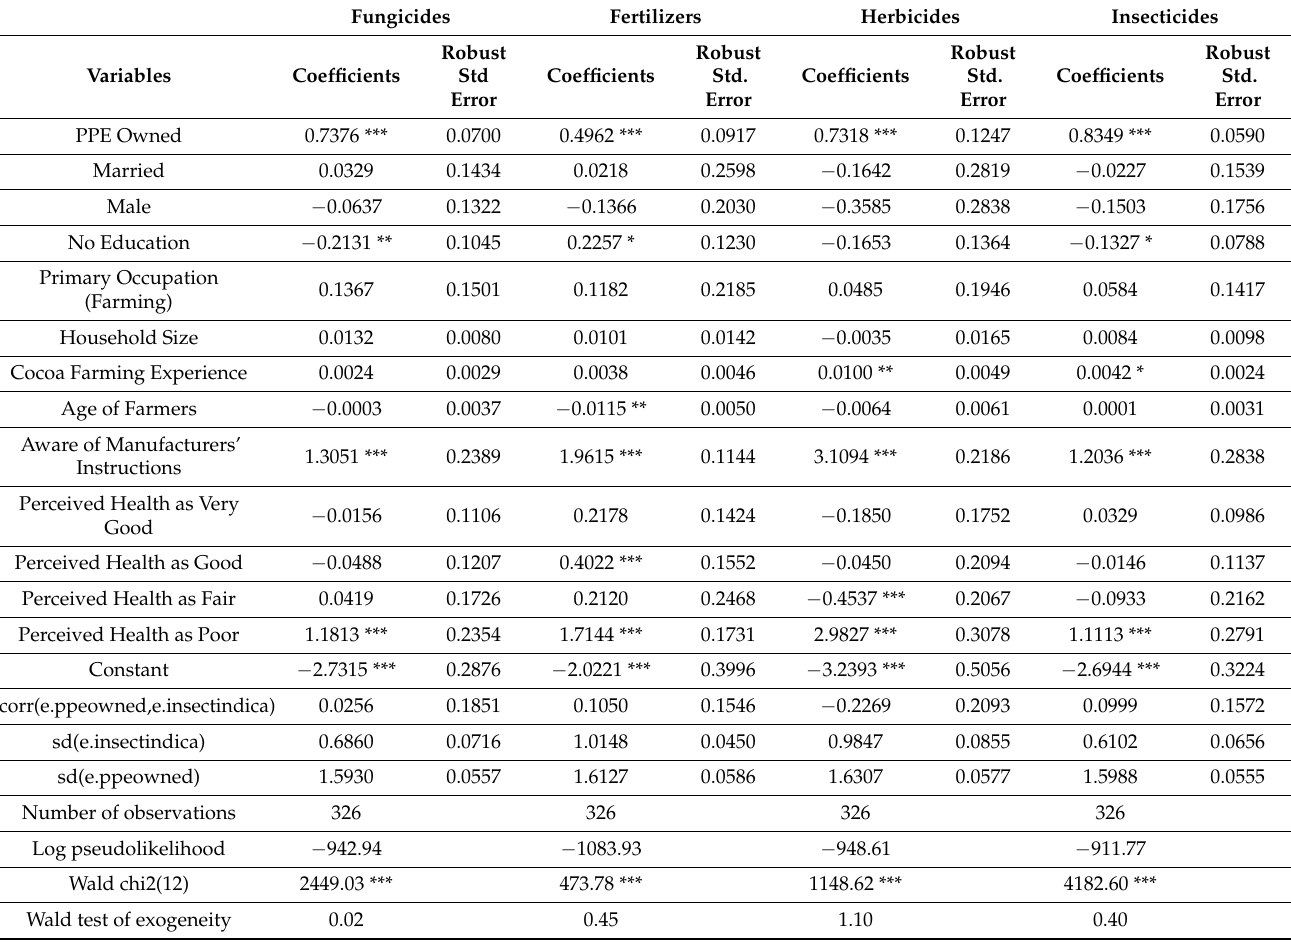
Table 4. Results of instrumental variable Tobit regression of the determinants of safety